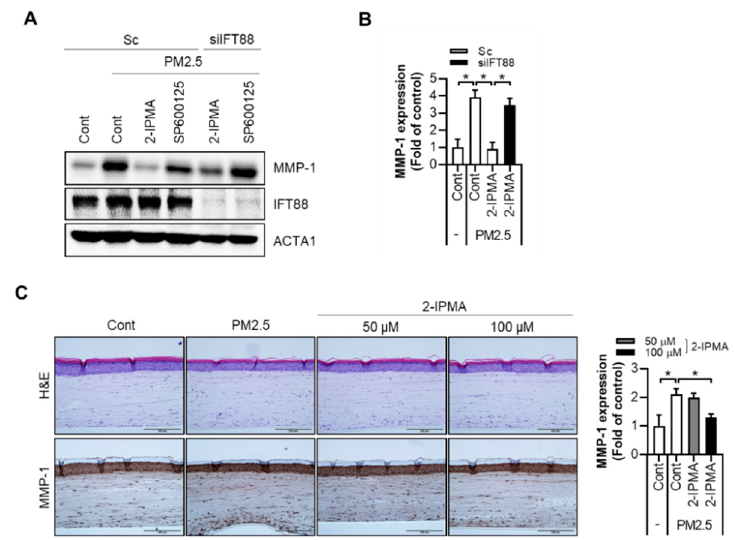
Figure 5. Primary cilia by 2-IPMA suppresses MMP-1 expression by PM2.5 in normal dermal fibroblasts and a 3-D-skin model. ( A , B ) Normal dermal fibroblasts transfected with either scrambled siRNA (Sc) or targeted siRNA to IFT88 (si IFT88 ) were treated with PM2.5 (50 μ g/mL) in the absence or presence of 2-IPMA (100 μ M) or SP600125 (10 μ M) for 24 h. Then, the cells were harvested and analyzed by Western blotting with the indicated antibodies ( A ). The expression of MMP-1 was quantified by densitometric image scanning of the Western blots ( B ) ( n = 3, * p < 0.05). ( C ) Full- thickness human 3-D-skin models were treated with PM2.5 (100 μ g/mL) in the absence or presence of 2-IPMA (50 or 100 μ M) for 48 h. Then, the tissues were subjected to histological examination. ( C ) H&E staining (upper) and MMP-1 immunohistochemistry (lower). Quantification of MMP-1 expression in the dermis. Data are presented as the mean ± SEM ( n = 3, * p < 0.05). Scale bar: 200 μ m.